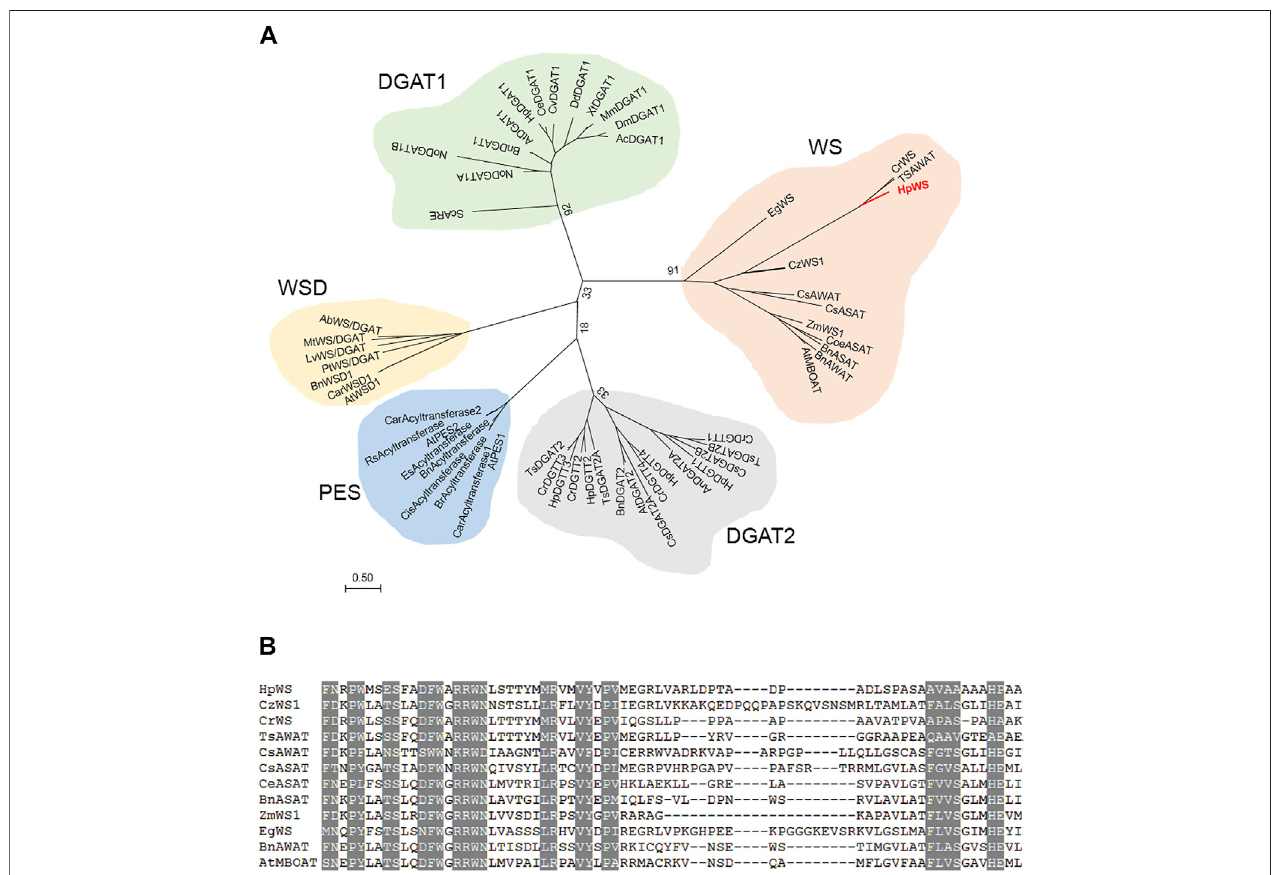
FIGURE1| PhylogeneticandalignmentanalysisofHpWS. (A) Phylogenetictreeofwaxsynthase(WS),diacylglycerolacyltransferase(DGAT),phytylestersynthase (PES),andbifunctionalWS/DGAT(WSD)fromvariousorganisms. (B) Conserved motifsinWSclade.Ab, Acinetobacter baylyi ;Ac, Apiscerana ;At, Arabidopsisthaliana ; An, Aspergillus niger ; Bn, Brassica napus ; Car, Capsella rubella ; Ce, Chlamydomonas eustigma ; Cis, Citrus sinensis ; Coe, Coffea eugenioides ; Cr, Chlamydomonas reinhardtii ; Cs, Chlorella sorokiniana ; Cv, Chlorella vulgaris ; Cz, Chromochloris zo fi ngiensis ; Dd, Dictyostelium discoideum ; Dm, Drosophila melanogaster ; Eg, Euglena gracilis ; Es, Eutrema salsugineum ; Hp, Haematococcus pluvialis ; Lv, Leptolyngbya valderiana ; Mm, Mus musculus ; Mt, Mycobacterium tuberculosis ; No, Nannochloropsis oceanica ; Pt, Phaeodactylum tricornutum ; Rs , Raphanus sativus ; Sc, Saccharomyces cerevisiae ; Ts, Tetrabaena socialis ; Xt, Xenopus tropicalis ; Zm, Zea mays. The accession numbers of these enzymes are listed in Supplementary Table S2